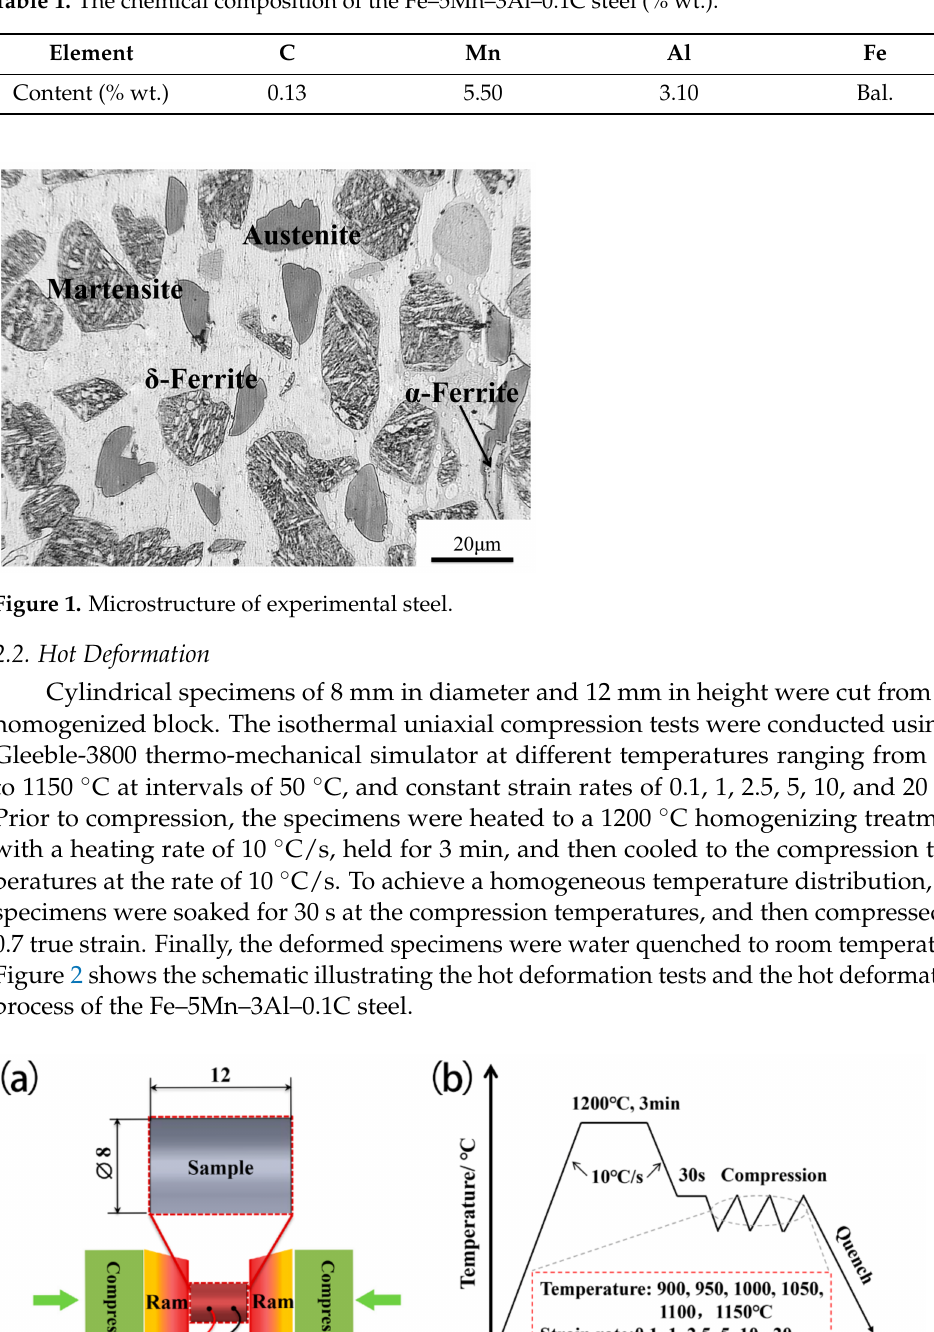
Table 1. The chemical composition of the Fe–5Mn–3Al–0.1C steel (% wt.).